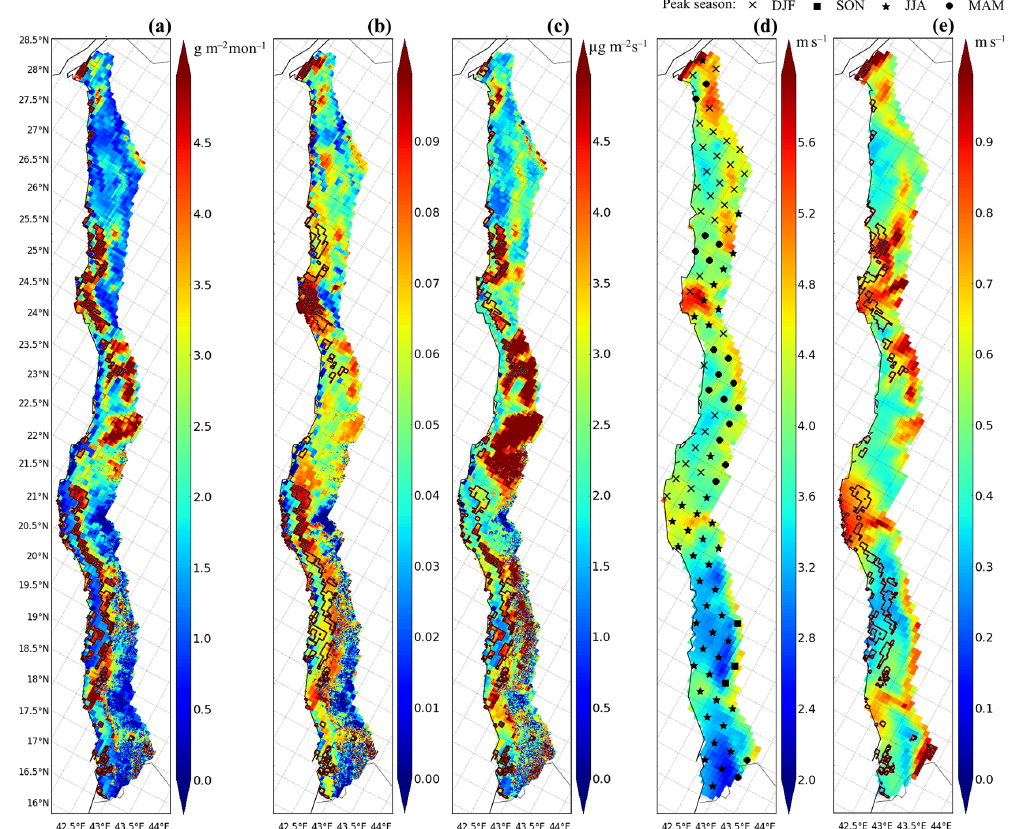
Figure 6. Standard deviations of monthly (a) total dust emission (gm − 2 month − 1 ), (b) dust event frequency, and (c) average emission intensity (µgm − 2 s − 1 ) in 1kmALL experiment with SEVIRI source function. Average 2009–2011 WRF forcing (d) wind speed (ms − 1 ), and (e) its monthly standard deviation (ms − 1 ). Peak season is indicated by symbols (see figure